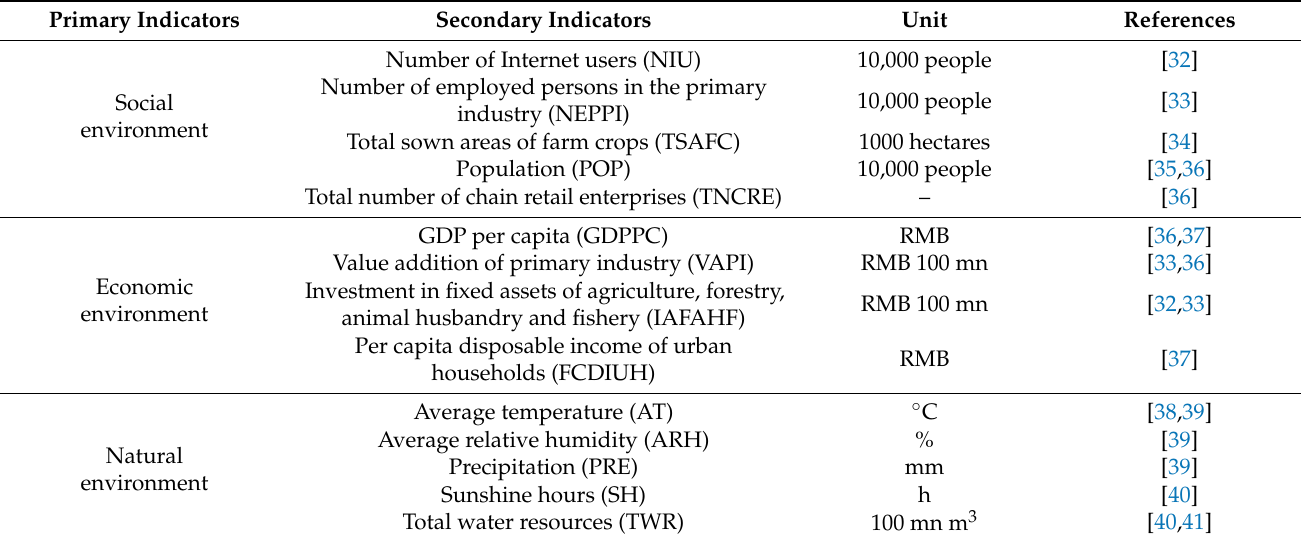
Table 2. Indicators of the influencing factors of the development of the